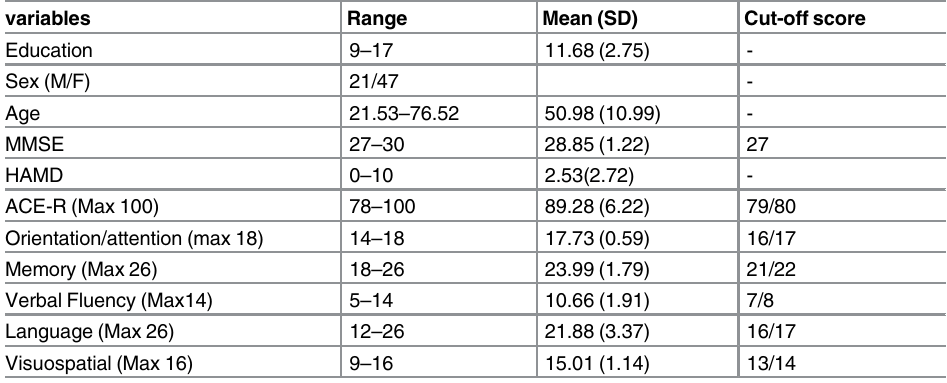
Table 2. Normative data of the healthy controls on the ACE-R (n =